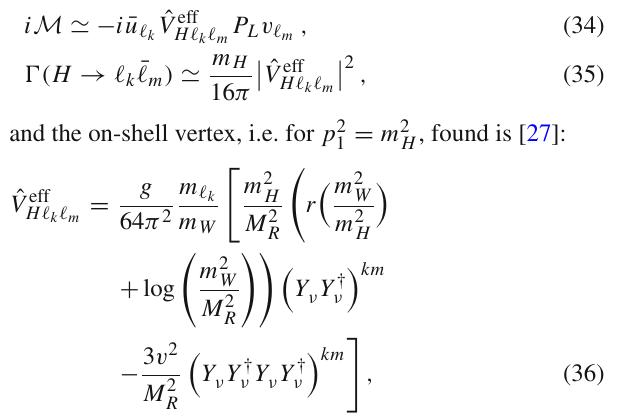
Fig. 6 Predictions for the partial width (cid:5)( Z → τ ¯ μ) and branching ratio BR ( Z → τ ¯ μ) as a function of M R . The dashed lines are the predictions from the MIA to O ( Y 2 ν + Y 4 ν ) . The solid lines are the pre- dictions from the full-one loop computation of the mass basis. Here the